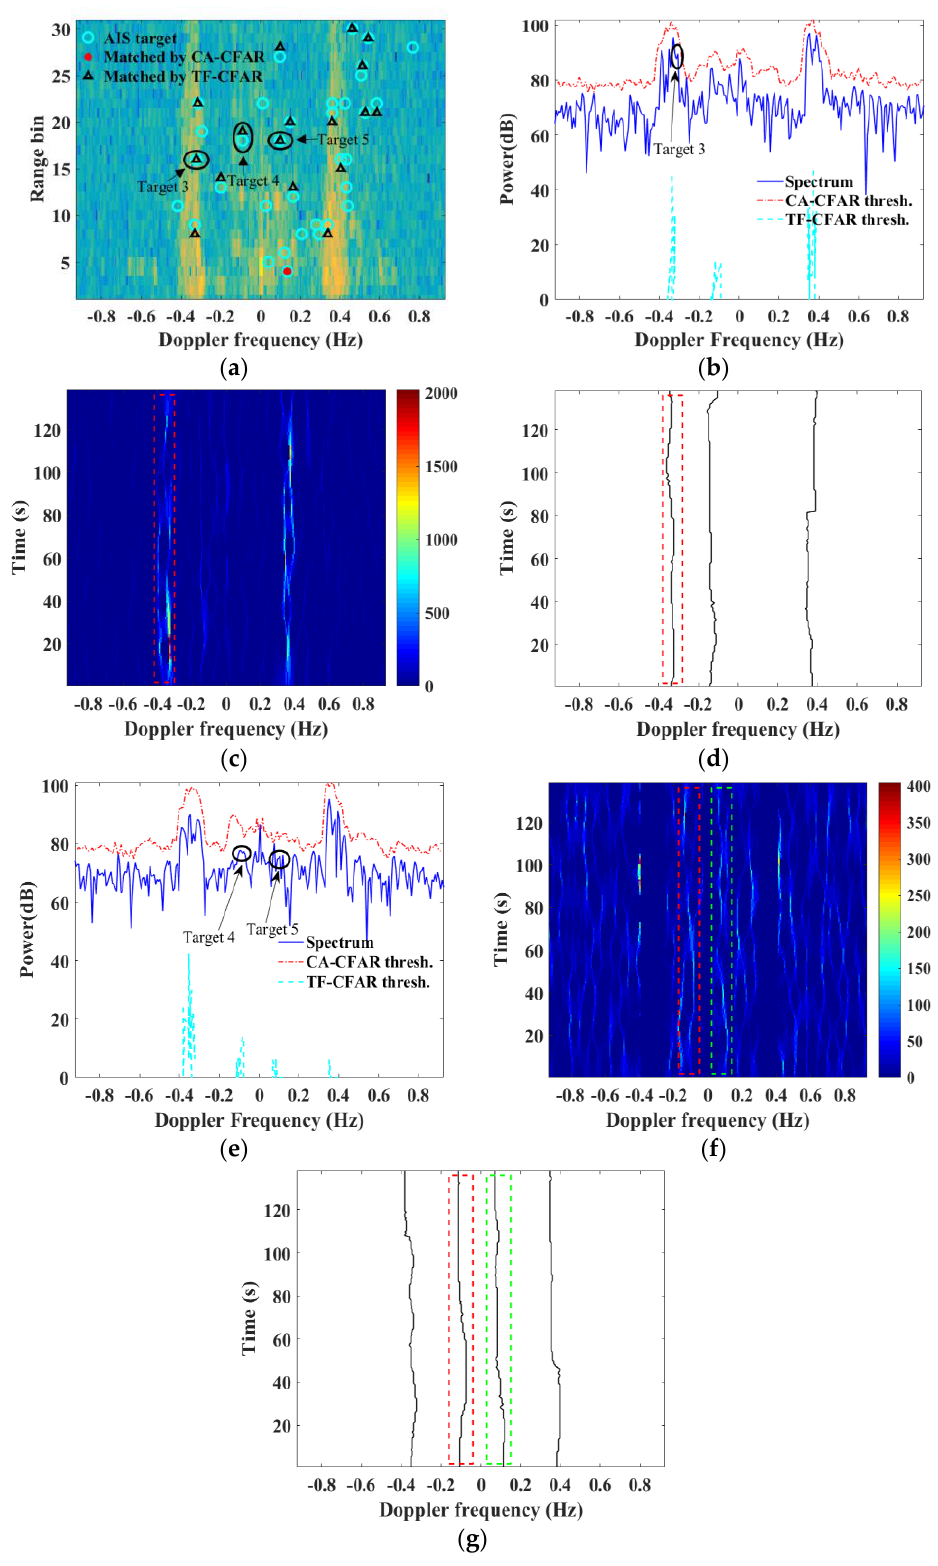
Figure 9. Target matched by TF-CFAR but unmatched by CFAR at 06:51 on 25 September 2015. ( a ) Target-matching RD map; ( b ) power spectrum at the 16th range bin; ( c ) TF image at the 16th range bin; ( d ) TF ridge extraction at the 16th range bin; ( e ) power spectrum at the 19th range bin; ( f ) TF image at the 19th range bin; ( g ) TF ridge extraction at the 19th range bin.